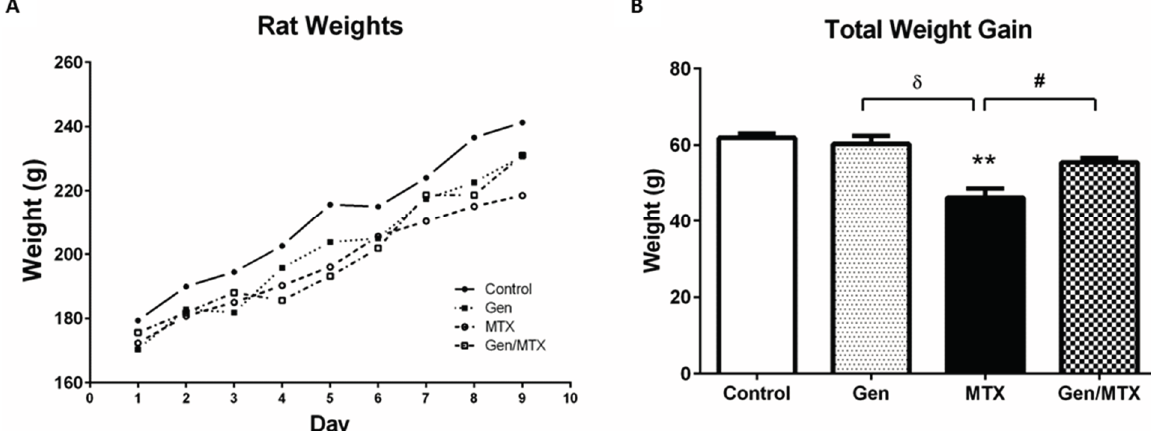
Figure 1. Effects of methotrexate (MTX) with/or without genistein on body weight gain. ( A ) Representative graph of weight accumulation over the period of treatment illustrating that MTX treatment (open circles, dashed line) slowed body weight gain, whilst the MTX and genistein combination (Gen/MTX, open square, dashed line) recovered their weight by the end of the trial; ( B ) Total body weight gained over the period of MTX administration until specimen collection. MTX significantly reduced weight accrual when compared to control group ( ** p < 0.01) or to the Gen alone group ( δ p < 0.001), and Gen supplementation (Gen/MTX) significantly attenuated the weight accrual suppression when compared to MTX alone group ( # p < 0.05) ( n =